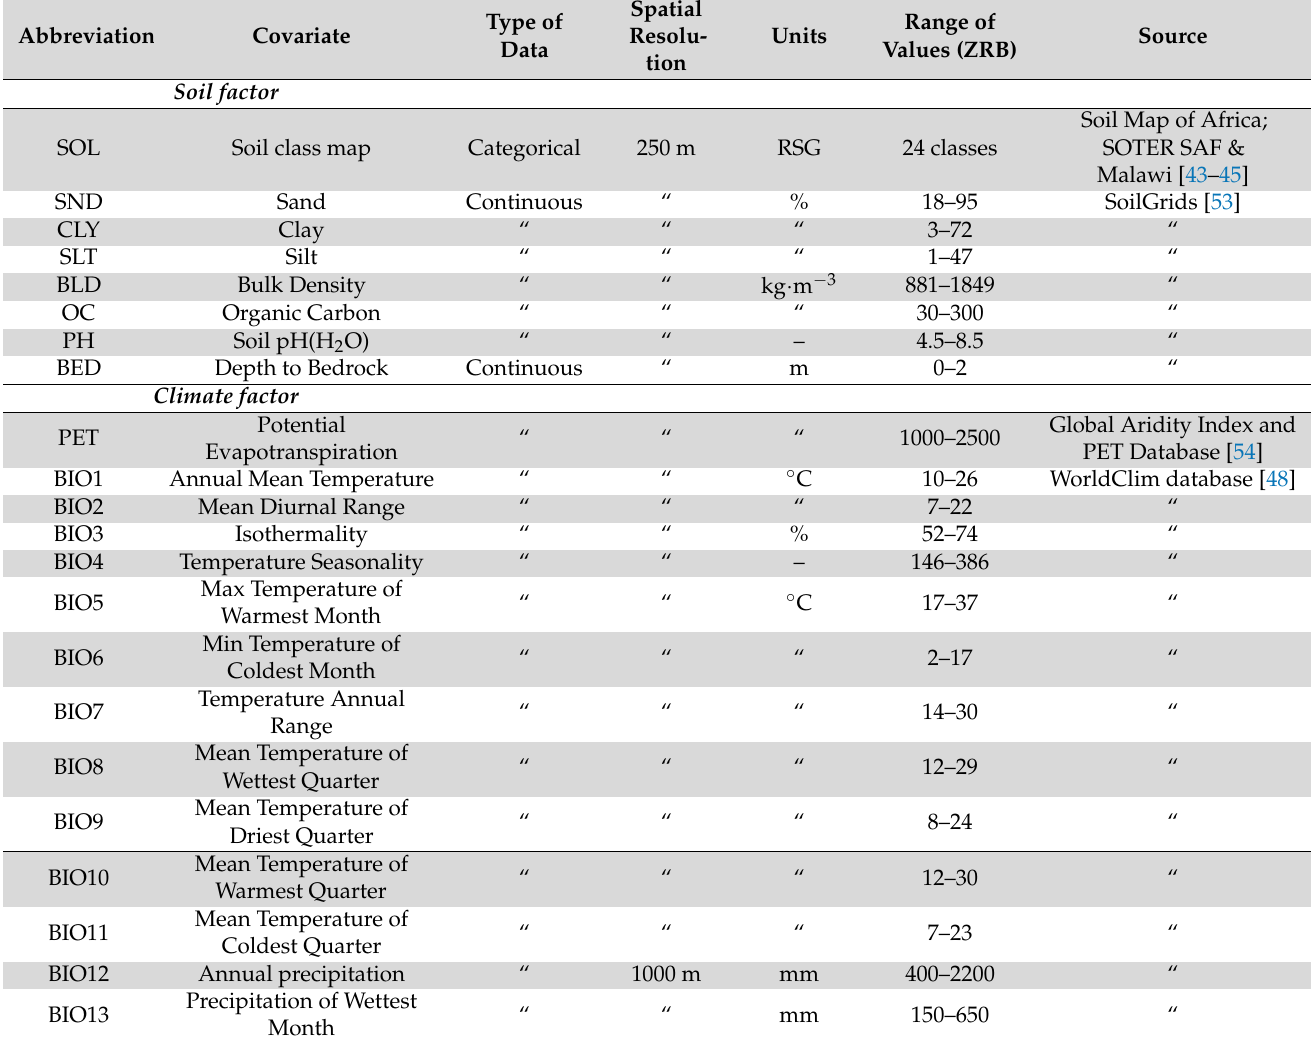
Figure 3. Six out of the total 67 examined SCORPAN covariates: elevation, land use, lithology, mean annual precipitation and evapotranspiration, and the soil class map. Legend of the categorical maps (soil, land use, and lithology) is presented in Table 2. Table 1. Soil environmental covariates and their abbreviations, type, spatial resolution, units and range of values listed as “SCORPAN